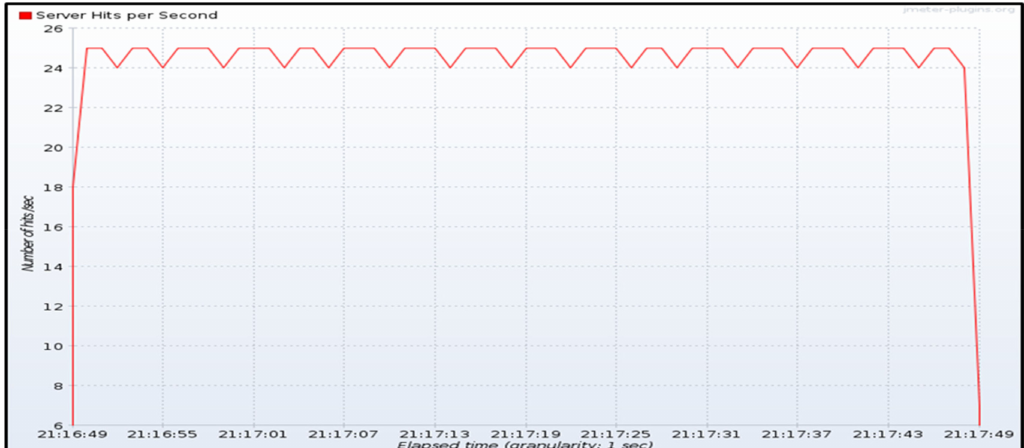
Figure 9. Throughput measured at JMeter source (~24 hits /